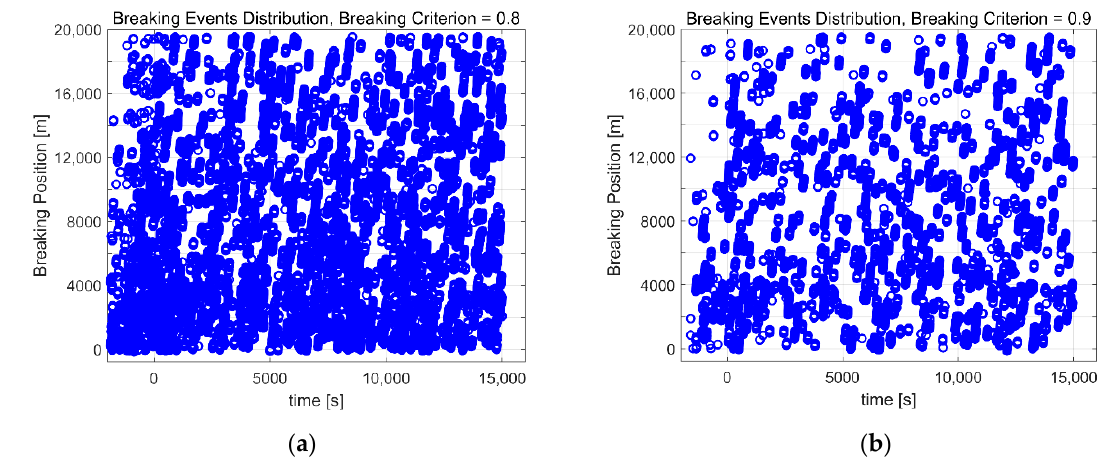
Figure 21. Breaking events distribution over the area (vertical) and time (horizontal) for U/C = 0.8 in ( a ) and U/C = 0.9 in ( b ).